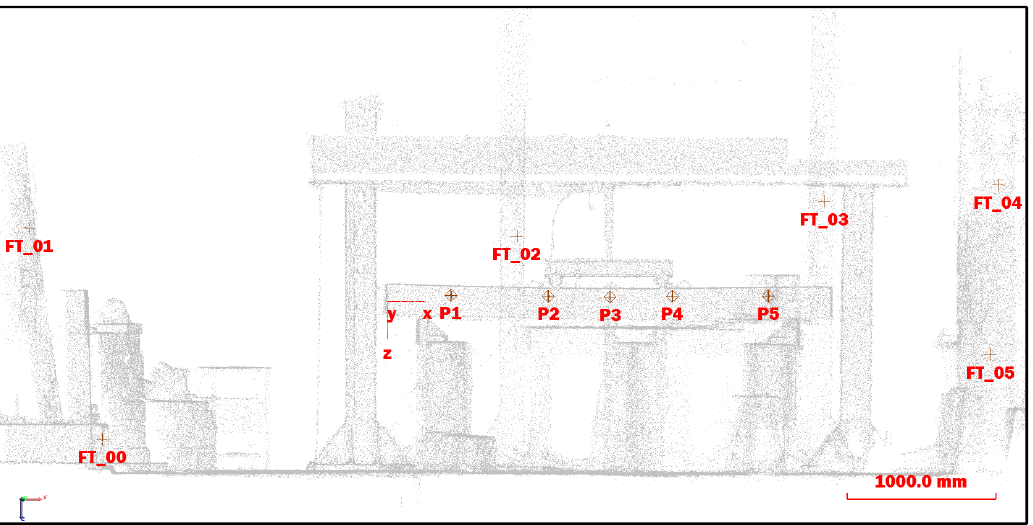
Figure 4. FT Targets and LT prism (P) location in the laboratory.